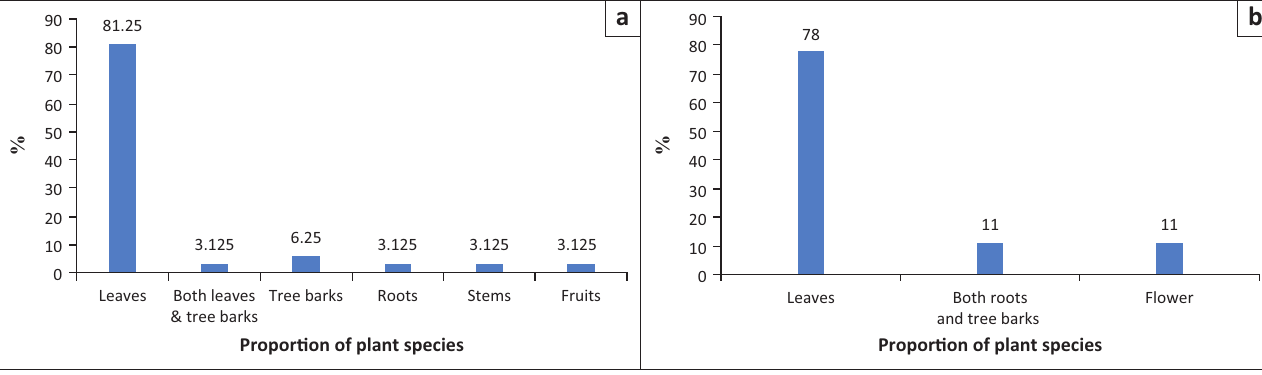
FIGURE 6: Proportion of plant parts used for human and cattle health problems: (a) Proportion of plant parts used for human health problems; (b) proportion of plant parts used for cattle health problems.